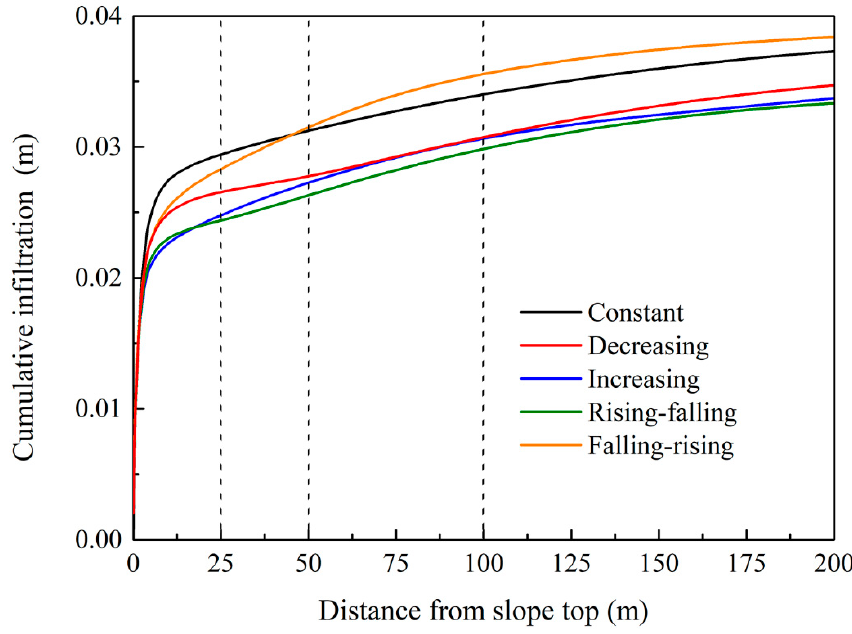
Figure 8. The cumulative infiltration distribution along the slope axis at the 15° slope.